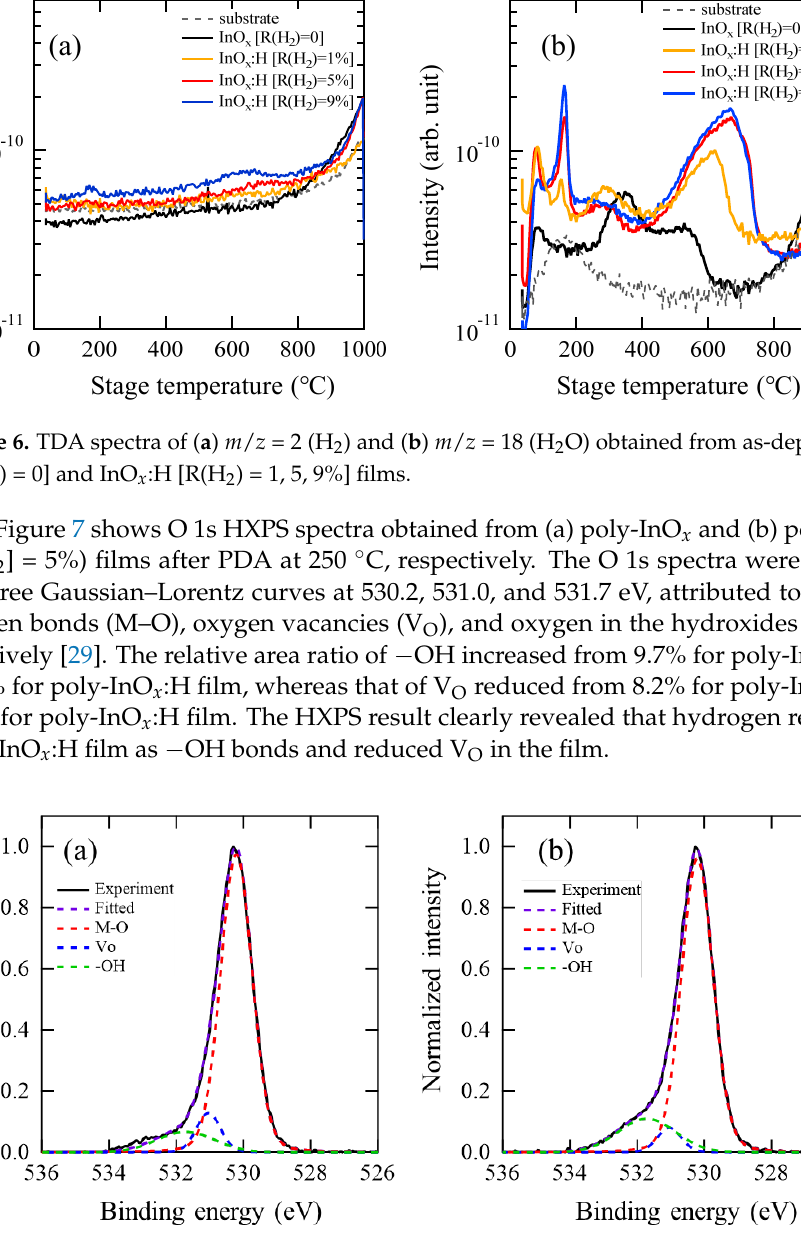
Figure 7. O 1s HXPS spectra obtained from ( a ) poly-InO x and ( b ) poly-InO x :H (R[H 2 ] = 5%) films after PDA in air at 250 °C.